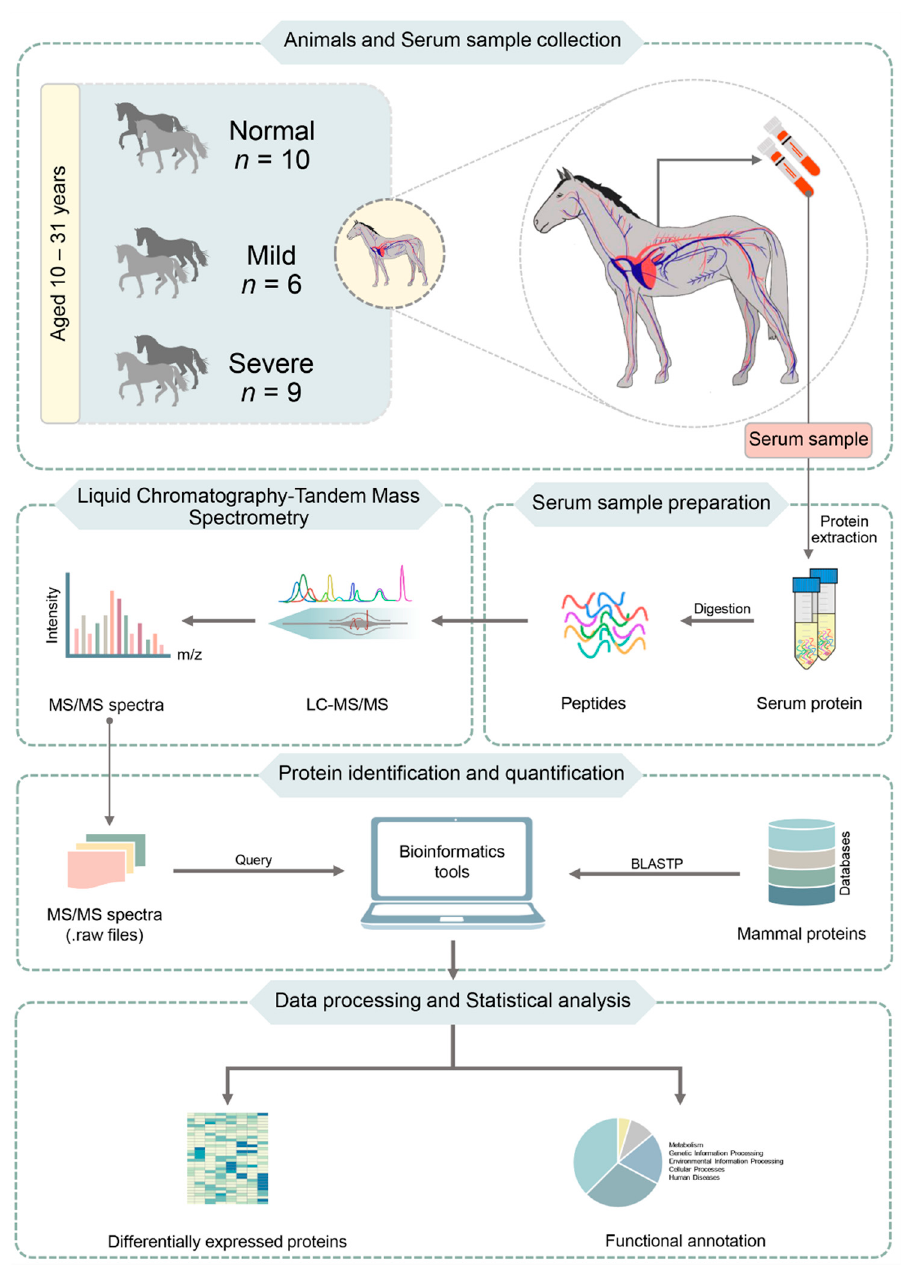
Figure 1. Flowchart of proteomic profiling towards DEP analysis and functional annotation. BLASTP (Protein BLAST) compares one or more protein query sequences to subject protein sequences in database. It allows to find regions of local similarity between protein sequences.